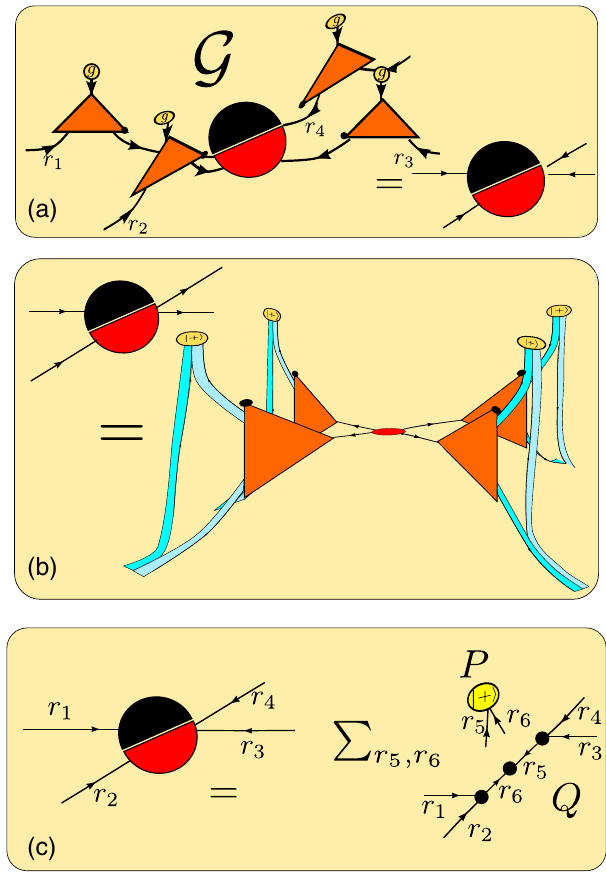
FIG. 19. (a) In gauge magnet LGT, the tensor G is an invariant G tensor; i.e., it is left invariant under multiplying all its legs by Γ g Þ . (b) G is obtained, for a finite group, by summing all the r ð representation matrices through the projector on the trivial representation. After projecting, the uniform superposition of all the states of the trivial representation is obtained by closing the free legs with the product of jþi . (c) For continuous gauge groups, the projector can either be written as an integral over the group elements with the appropriate invariant measure or it can be obtained by using the Clebsch-Gordan coefficients, which trans- form the product of the four representations into a direct sum of irreps, and then by projecting onto to the trivial